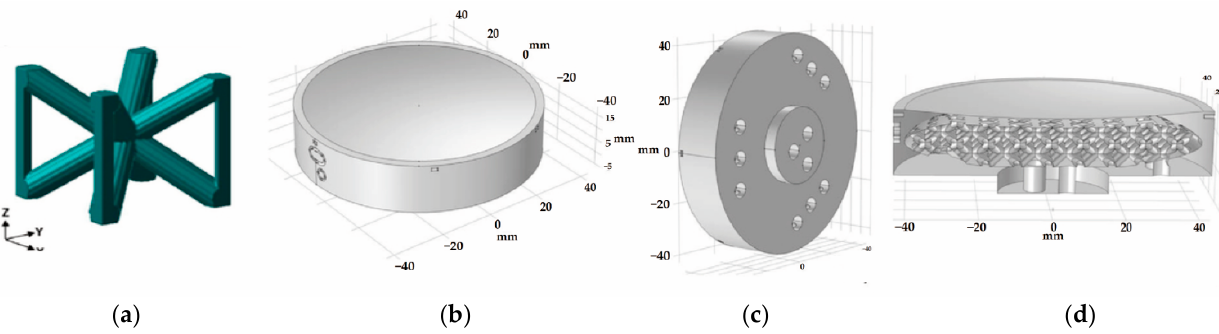
Table 6. Experimental methods and results